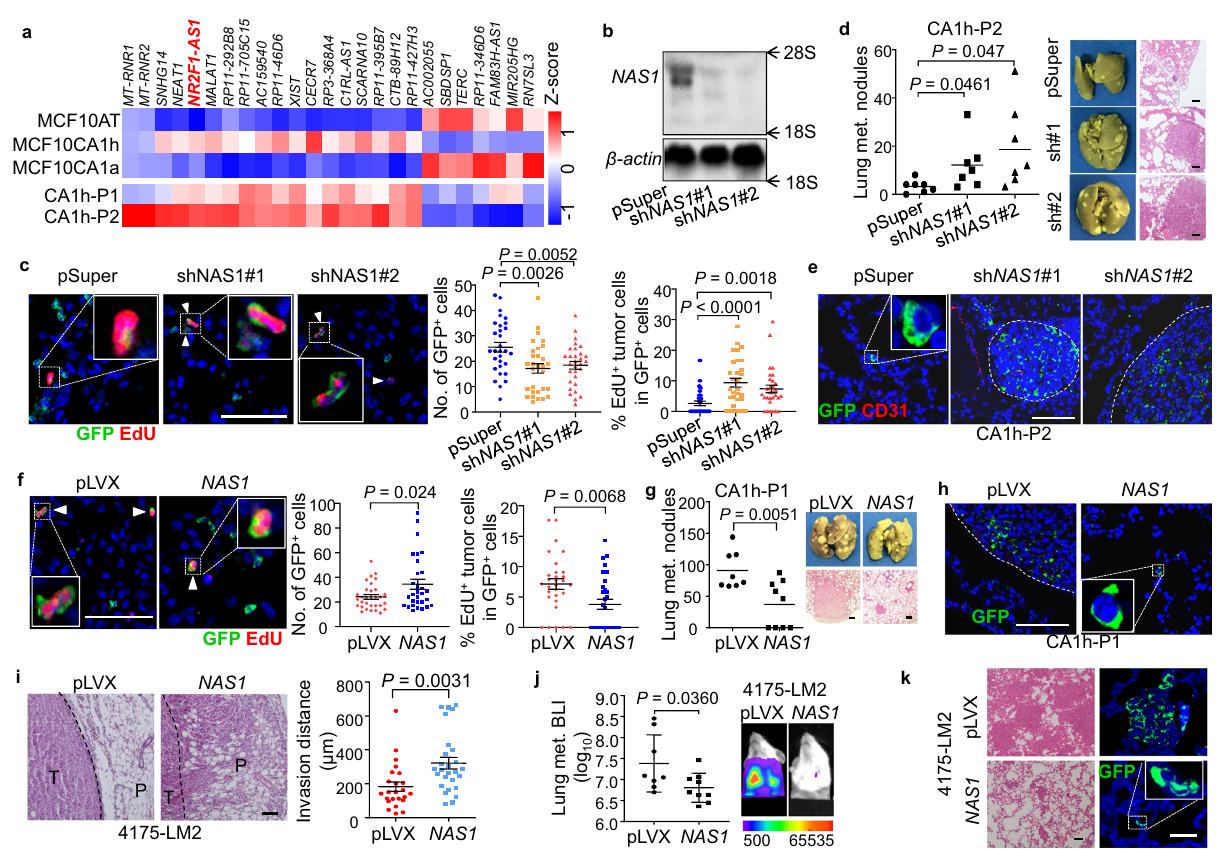
Fig. 2 NR2F1-AS1 ( NAS1 ) promotes metastatic dormancy of breast cancer. a Expression heatmap of differential lncRNAs in MCF10 cell lines. b Northern blot of NAS1 in CA1h-P2 after NAS1 knockdown, with 18S and 28S ribosomal RNAs as the markers. Northern blotting was repeated three times independently with similar results. c Analyses of total and proliferative GFP + tumor cells seeded in lungs 4 days after intravenous injection of CA1h-P2 with NAS1 knockdown ( n = 30 RMFs from 3 mice of each group). The triangles indicate GFP and EdU double-positive cells. d Numbers of pulmonary nodules 4 months after intravenous injection of CA1h-P2 with NAS1 knockdown ( n = 7 mice in each group). e IF staining of lung tissue sections in ( d ). f Analyses of total and proliferative GFP + tumor cells seeded in lungs 4 days after intravenous injection of CA1h-P1 with NAS1 overexpression ( n = 30 RMFs from 3 mice). The triangles indicate GFP and EdU double-positive cells. g Number of pulmonary nodules 4 months after intravenous injection of CA1h-P1 with NAS1 overexpression ( n = 8 and 9 mice without or with NAS1 overexpression, respectively). h IF staining of lung tissue sections in ( g ). i H&E staining (left) and invasion depth (right) of tumor edges after orthotopic injection of NAS1 -overexpressing 4175-LM2 cells in NOD/SCID mice ( n = 24 and 27 RMFs from 8 and 9 mice, respectively). j BLI quanti fi cation (left) and representative images (right) of lung metastasis of the mice in ( i ) 9 weeks after injection ( n = 8 and 9 mice without or with NAS1 overexpression, respectively). k H&E and IF staining of lung tissue sections in ( j ). H&E and IF staining in e , h , k were performed on lung sections of three mice in each group with similar results, and representative images were shown. Scale bar, 100 μ m. Data represent mean ± SD ( j ), mean ± SEM ( c , f , I ), or mean with data points ( d , g ). Statistical signi fi cance was determined by a two-tailed unpaired t test ( c , d , f , g , i ) or two-sided Mann – Whitney test ( j